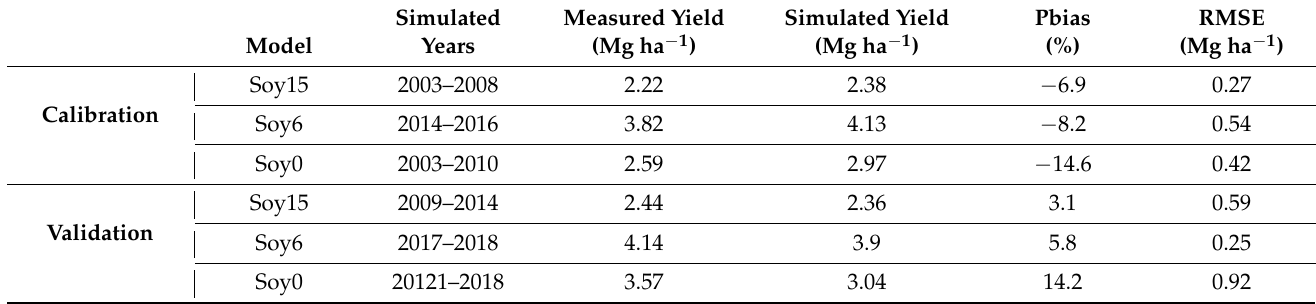
Table 7. Simulation results of model calibration and validation for three soybean sprout cultivars of Soy15, Soy6, and Soy0 (measured and simulated yields were averaged across cultivars and years).